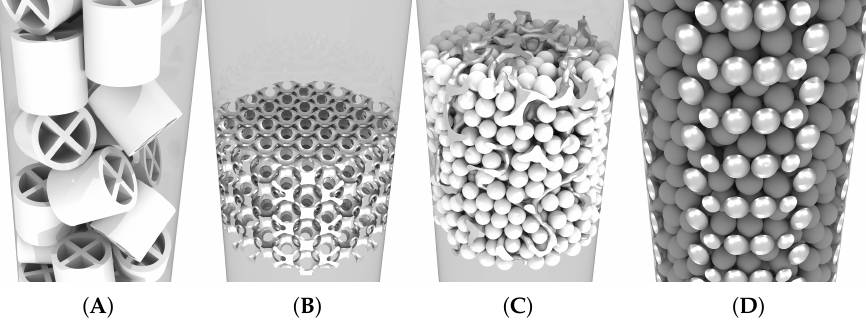
Figure 2. Recent process intensification concepts for catalytic flow reactors: ( A ) Complex particle shapes, ( B ) Periodic open cell structures, ( C ) Packed foams and ( D ) Macroscopic wall